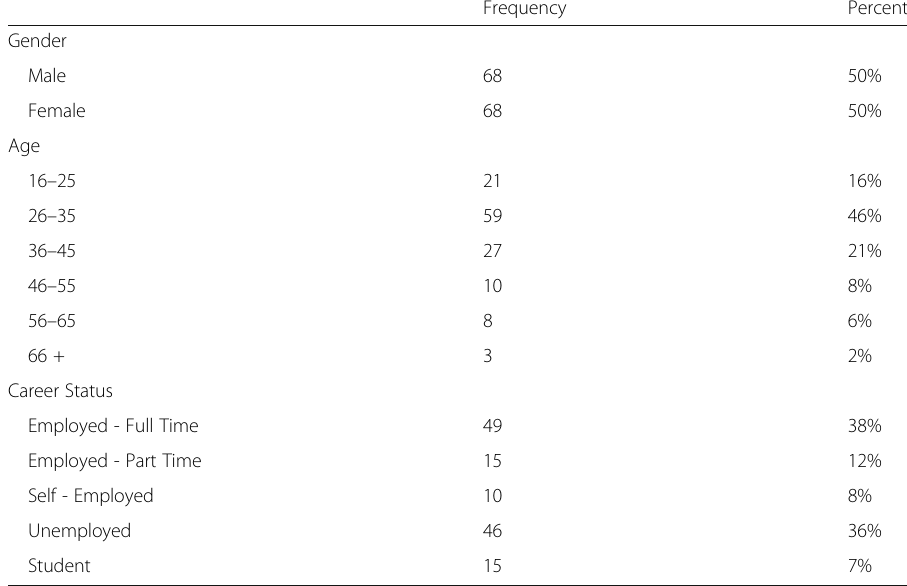
Table 1 Participants demographic details ( n =